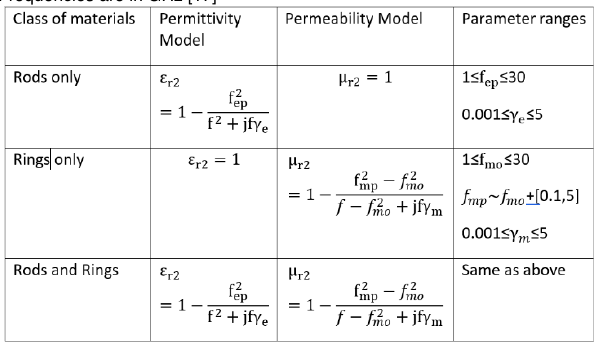
TABLE I. List of three types of Metamaterials used for the simulations. Frequencies are in GHz [17]